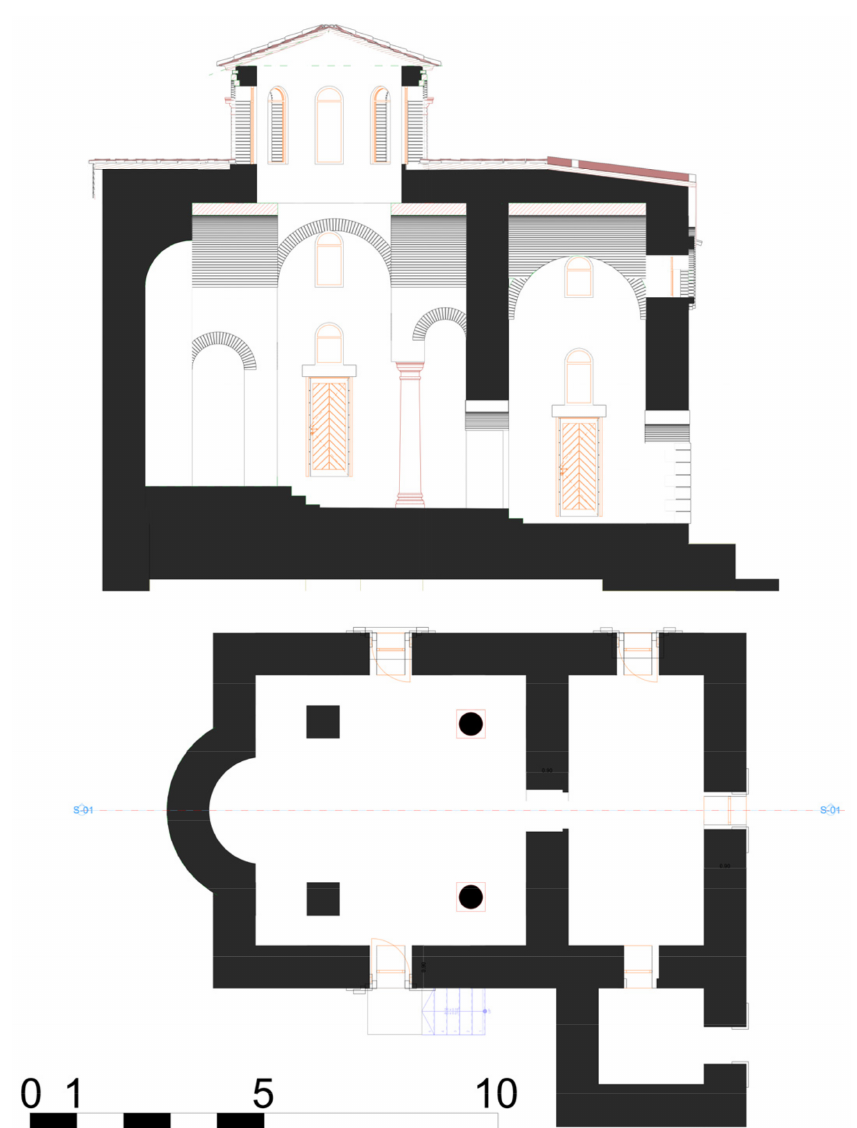
Figure 8. Plan layout and longitudinal section of the Holy Trinity’s church of Berat. Provision courtesy of Arch. Arsim Murseli, UBT University.